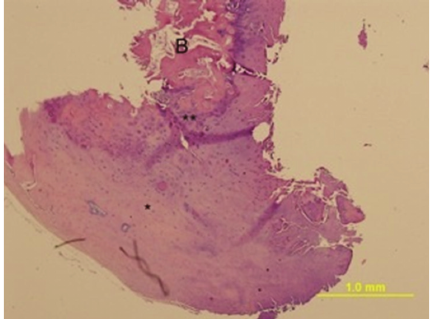
Figure 3: Photomicrograph of the resected lesion shows the bluish cartilage cap ( ∗ ) demarcated from the underlying trabecular bone (B) by the secondary ossification line ( ∗∗ ). Hematoxylin and eosin